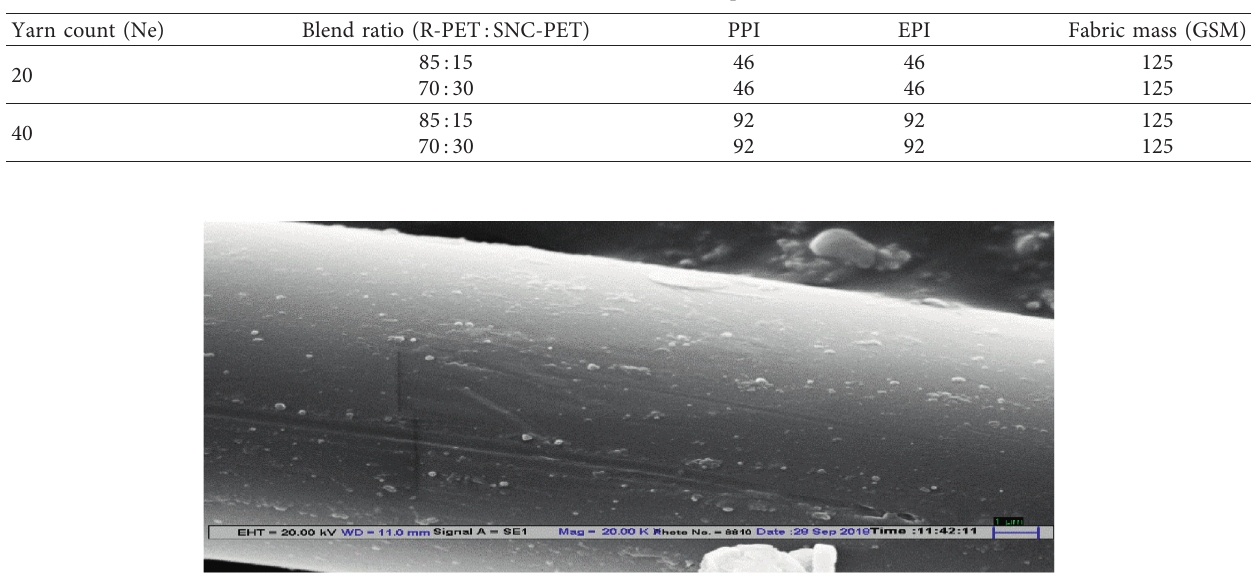
Figure 2: SEM images of silver nanocomposite PET. Table 5: Thermal properties of fibers calculated from DSC curves.